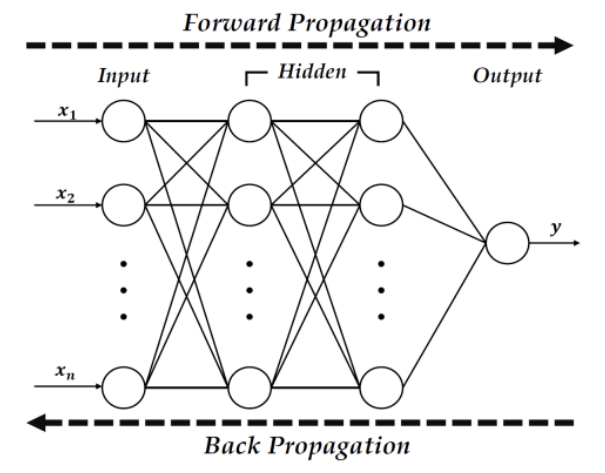
Figure 1. Structure of Back-propagation Neural Network.